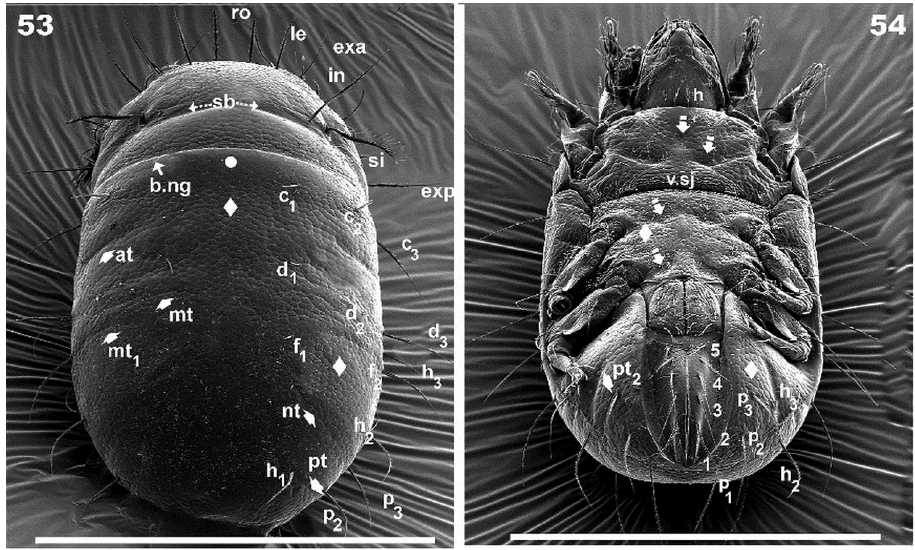
Figures 53–54. Torpacarus eidikoterai sp. n. Adult female with cerotegumental layer. SEM micrographs. 53 dorsal anteroposterior view 54 ventral anteroposterior view. Scale bars: 500